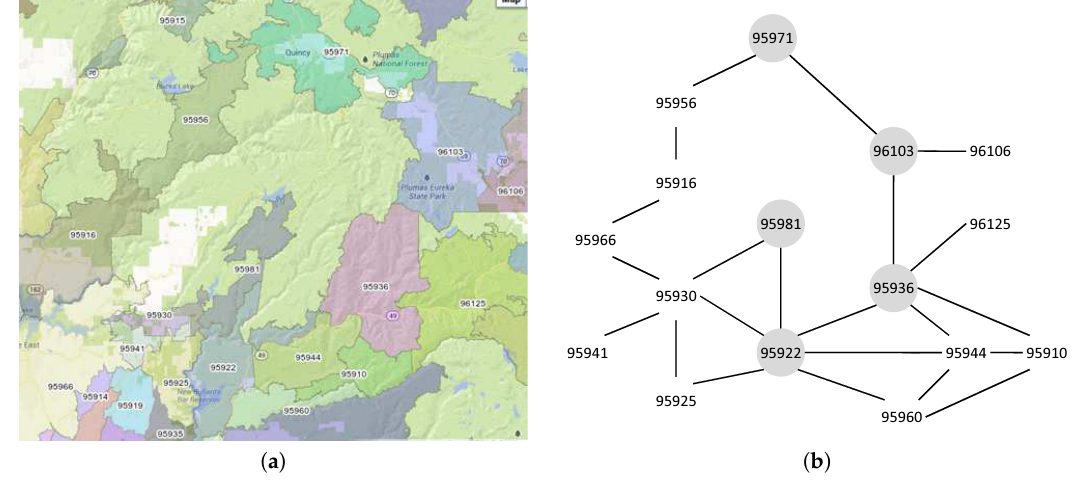
Figure 15. Mountain-separated ZIP code graph. ( a ) map; ( b ) ZIP code